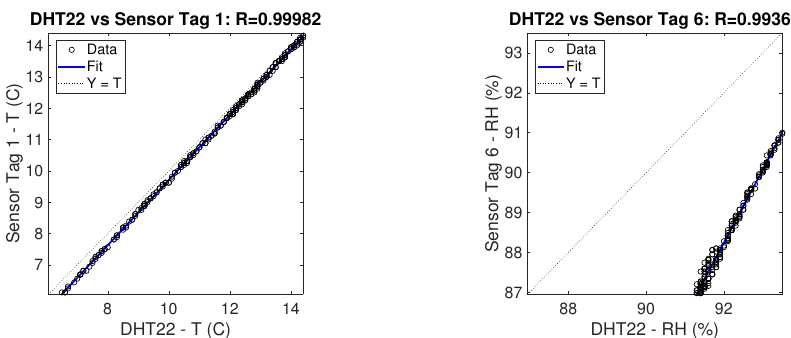
Figure 11. Correlation between DHT and Sensor tag sensors - Temperature and Relative Humidity.